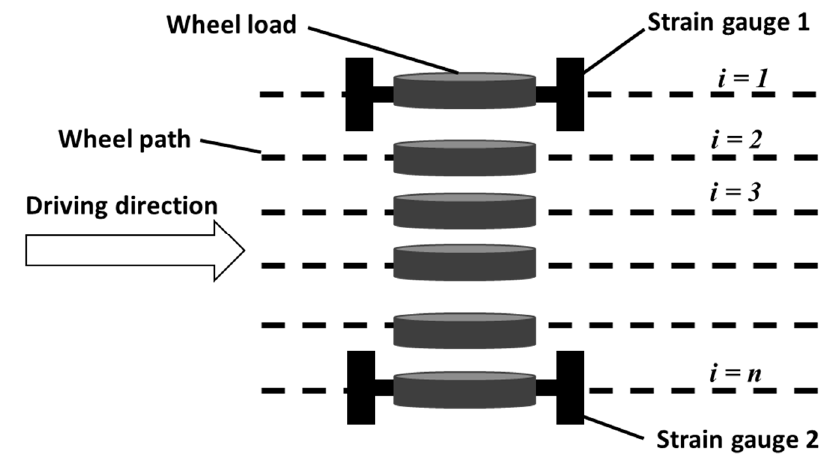
Figure 2. Different offsets of the wheel load.